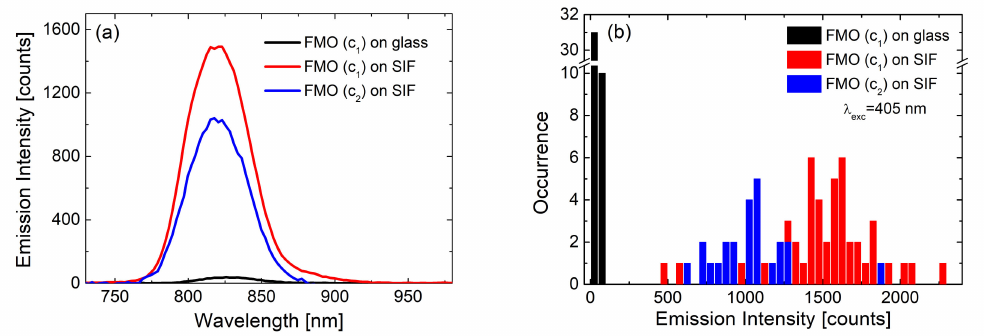
Figure 5. ( a ) Comparison between the emission spectra of FMO on glass (black line for concentration c 1 ) and on SIF (red line and blue line for concentration c 1 and c 2 respectively) excited at 405 nm; ( b ) corresponding histograms of the maximum emission intensities of FMO on glass (black bars) and on SIF (blue and red